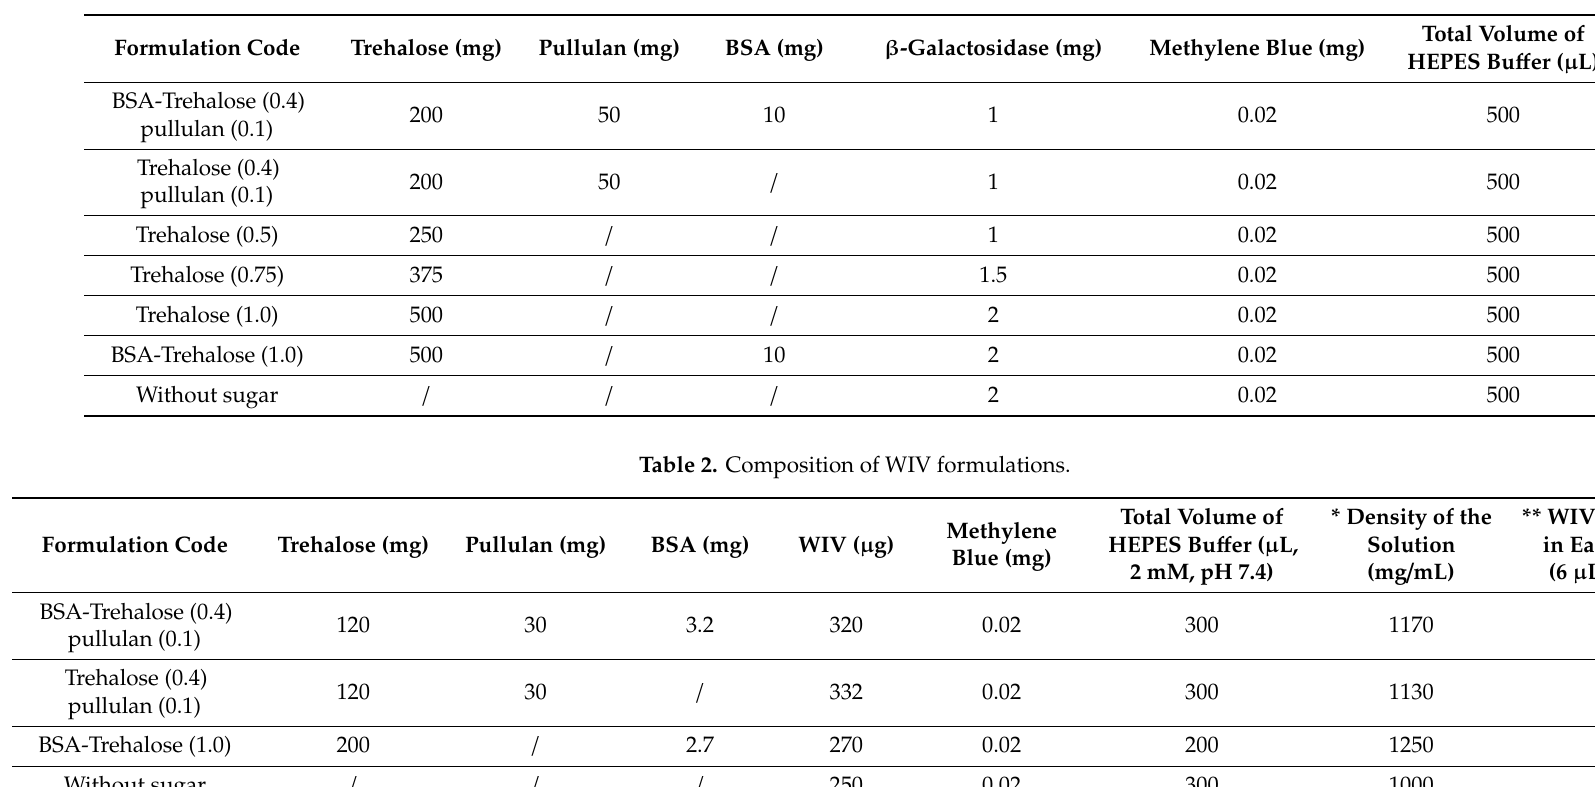
Table 1. Composition of β -galactosidase formulations.